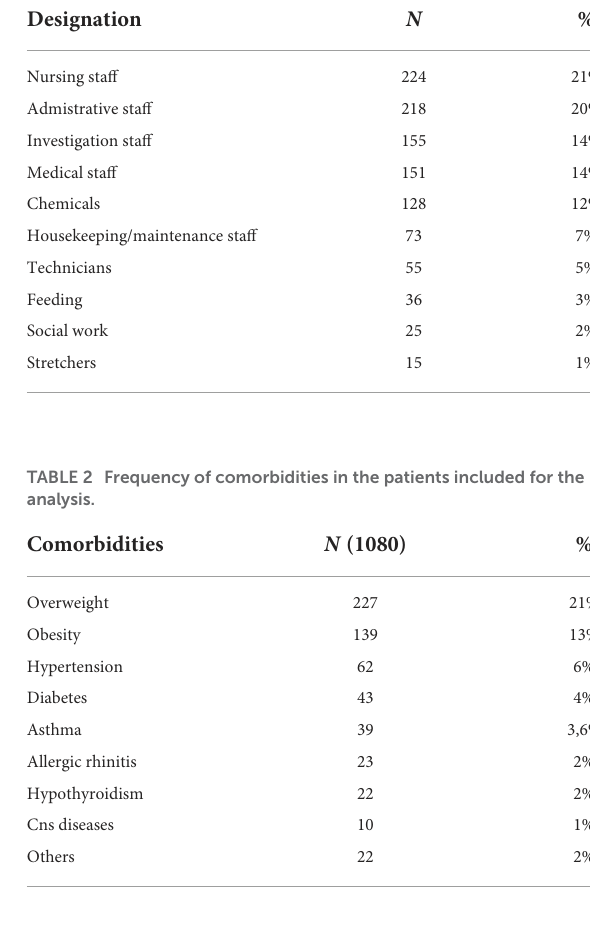
TABLE 1 Designations of the tested personnel.